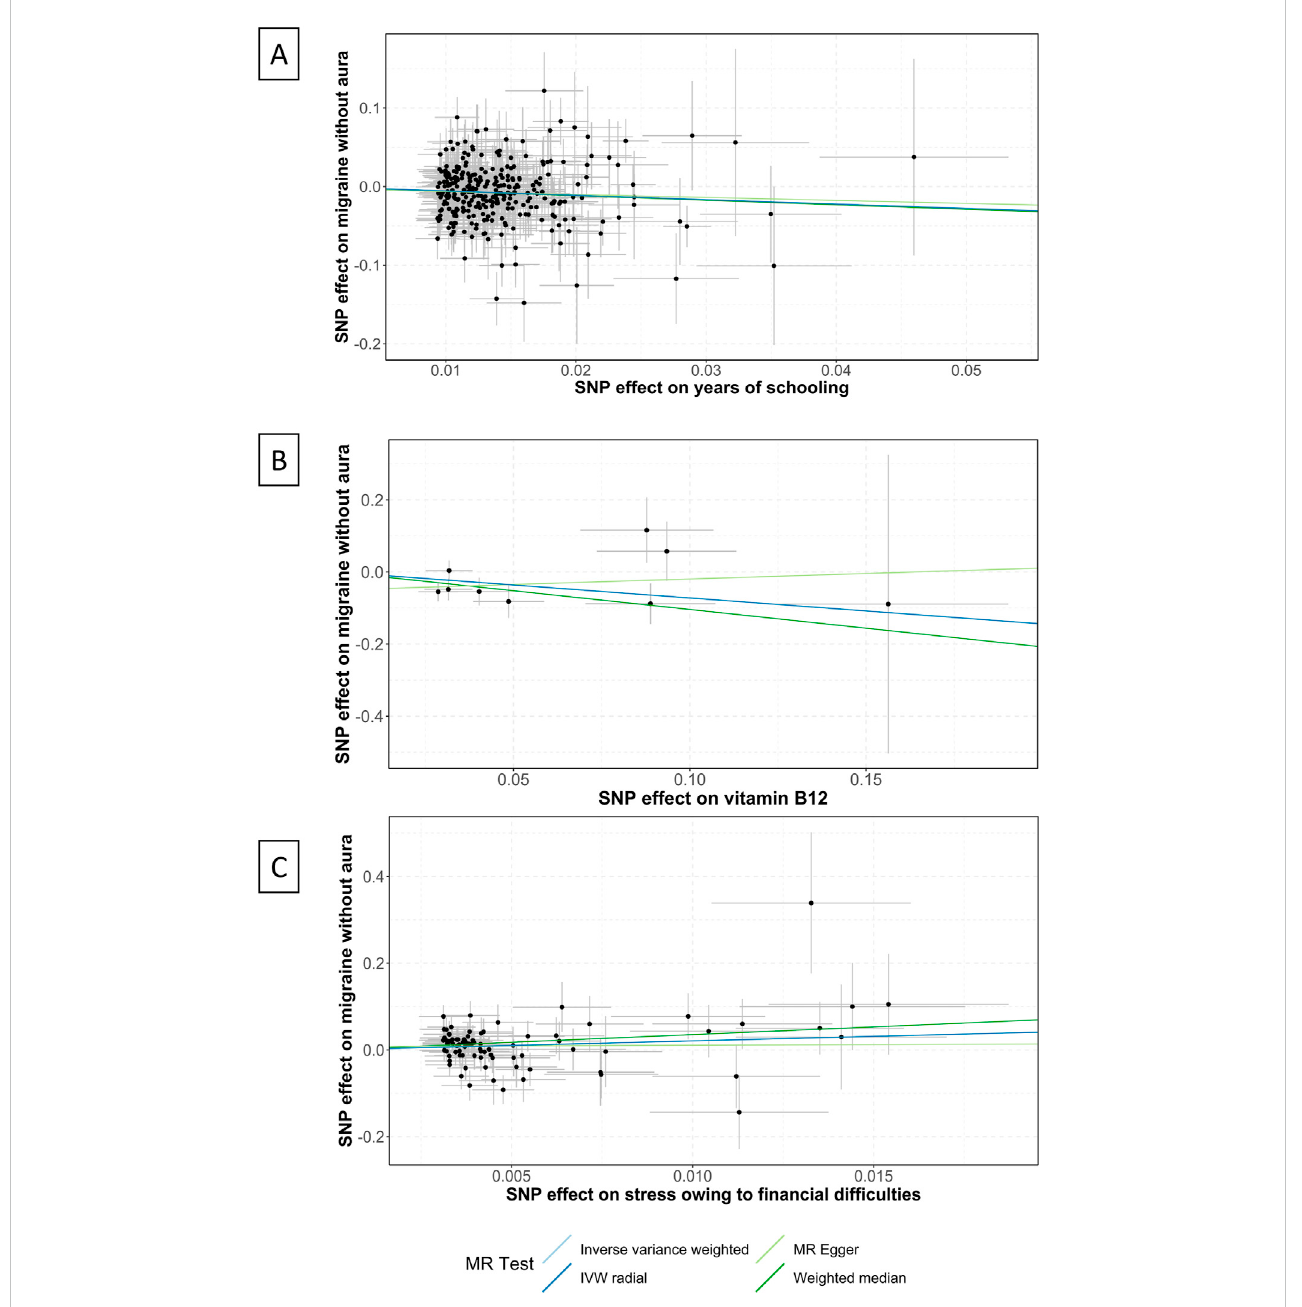
FIGURE 2 Scatter plots of the association between years of schooling, vitamin B12, and stress and migraine without aura. IVW, inverse variance weighted; MR, Mendelian randomization; SNP, single nucleotide polymorphisms. Annotation: Scatter plots of the migraine-SNP associations ( y -axis) versus the exposures- SNP associations ( x -axis) were shown, with vertical and horizontal lines showing 95% con fi dence intervals. The fi tted curves among the dots refer to the differential statistical analysis methods. The MR analyses were performed with the inverse variance weighted method, the MR-Egger method, the weighted median method, and the IVW radial method. (A) shows the scatter plot for years of schooling, (B) shows the level of vitamin B12, and (C) shows the stress owing to fi nancial dif fi